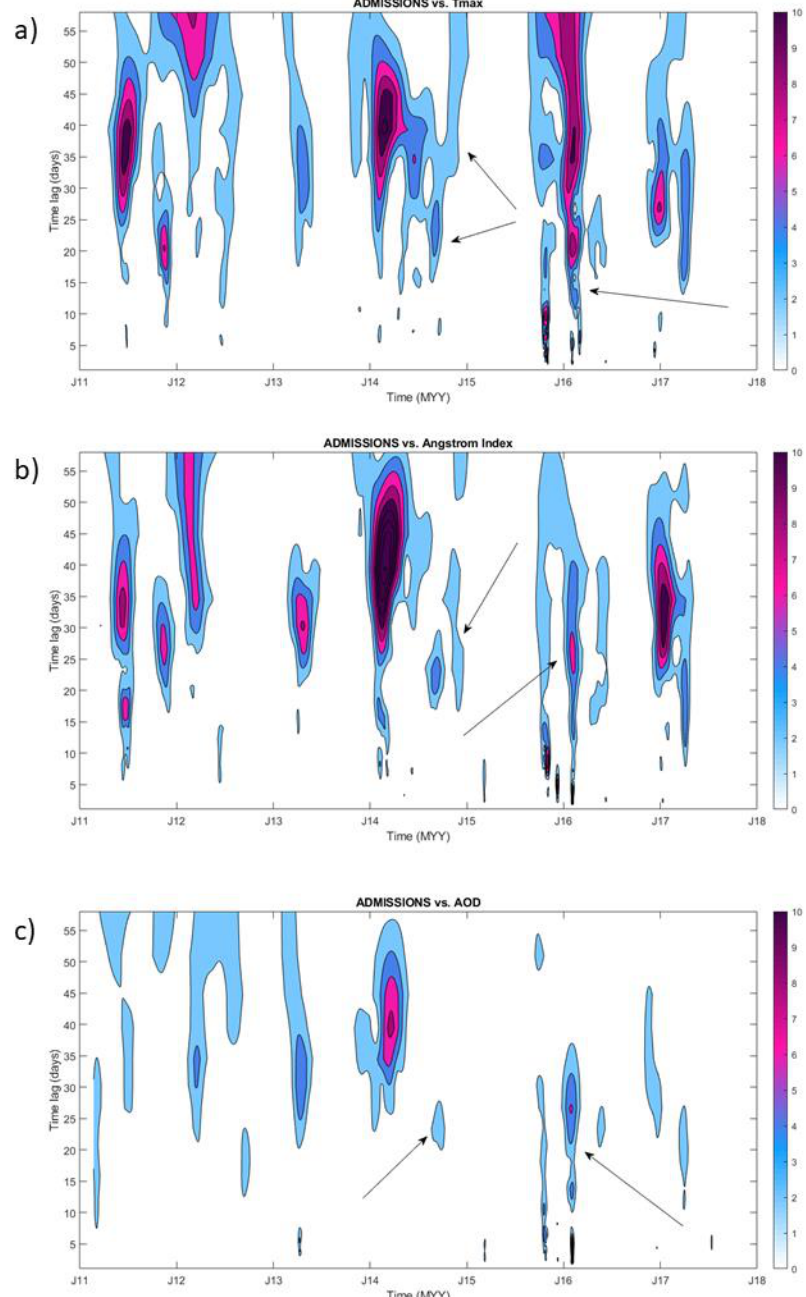
Figure 3. Local cross-correlation wavelet spectra of all admissions records versus ( a ) Tmax, ( b ) AE, and ( c ) AOD data, for the entire period of hospital admissions recording. Arrows point to values in local cross-correlations space that appear at the time of the dust storm event. The color scale codes the values of wavelet cross-correlation coefficients |𝐶𝐸 𝑥,𝑦 (𝑎, 𝑏)| .